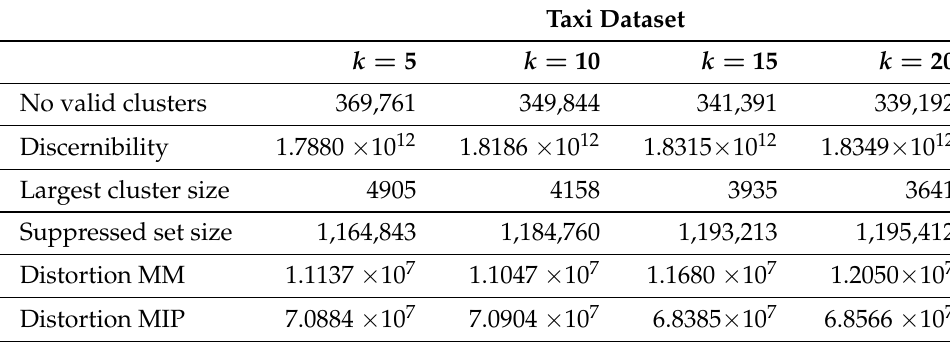
Table A1. Study of discernibility and distortion with a varying k on a large taxi